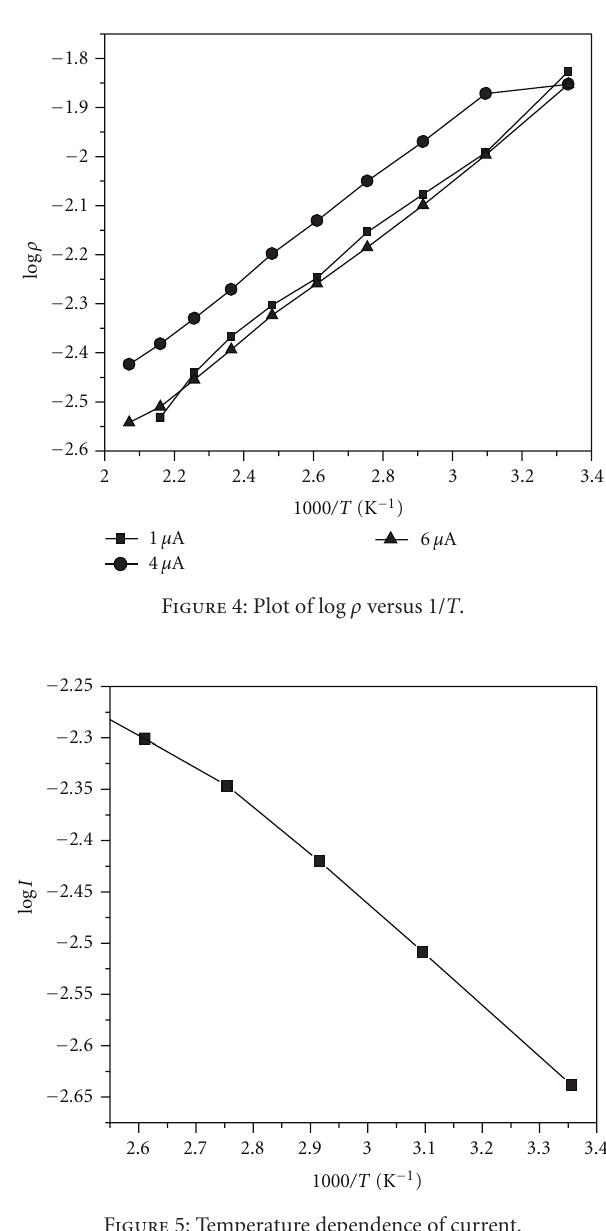
Figure 5: Temperature dependence of